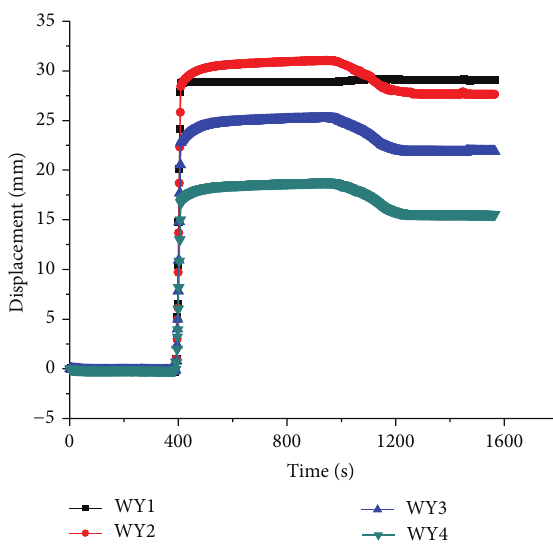
Figure 7: The displacement on top of topsoil.